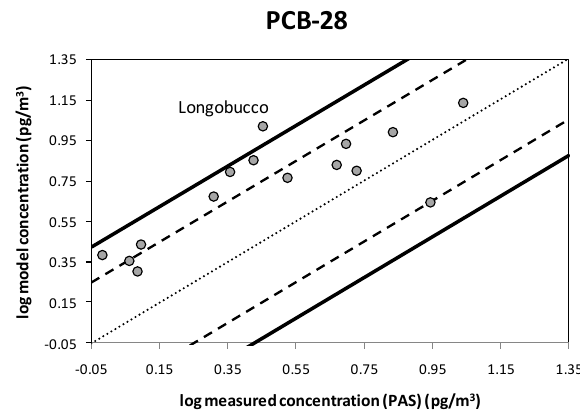
Fig. 3. Modelled versus observed (PAS) air concentrations for PCB- 28 at selected sites. The dashed and solid lines represent agreement within a factor of 2 and 3,